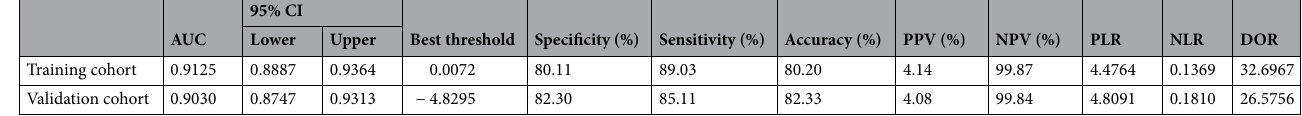
Table 4. Prediction performance of the nomogram for the risk of diabetes. AUC, Area under curve; CI, Confidence interval; PPV, Positive predictive value; NPV, Negative predictive value; PLR, Positive likelihood ratio; NLR, Negative likelihood ratio; DOR, Diagnostic odds ratio. The algorithm of diabetes risk in LASSO model: Model = − 23.14183 + 0.03224* age (year) + 0.10645* BMI (kg/m 2 ) + 0.01388* SBP (mmHg) +